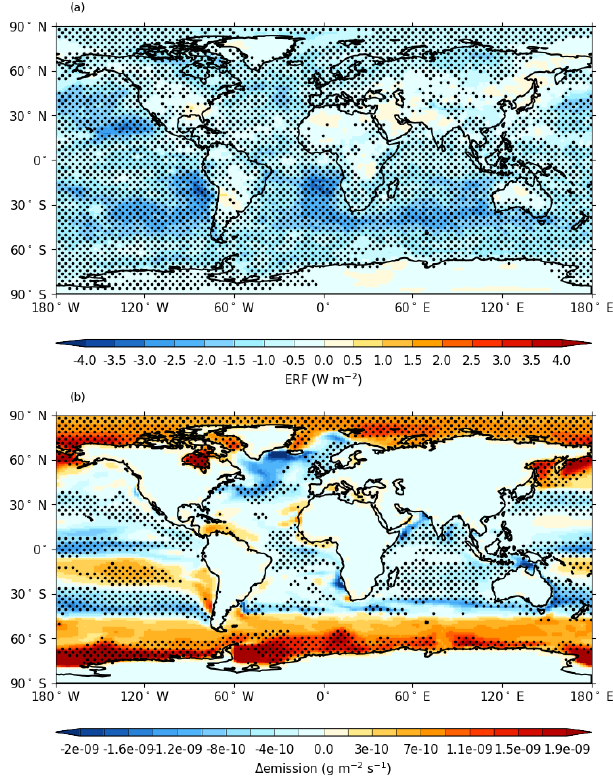
Figure 2. Multi-model mean (a) ERF from piClim-2xss vs. piClim- control , (b) change in sea salt emissions for abrupt-4xCO2 vs. pi- Control . CNRM-ESM2-1 emissions are excluded from the multi- model emissions in panel (b) as they include a coarse bin which dominates. Stippling shows areas where the mean changes by more than the standard deviation across models.